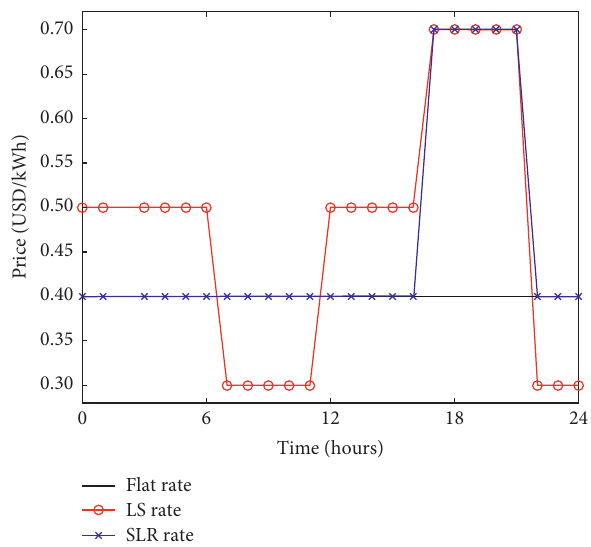
Figure 6: Different TOU pricing schemes for the implementation of DSM programs. Table 1: Self-elasticity and cross-elasticity factors for SLR.